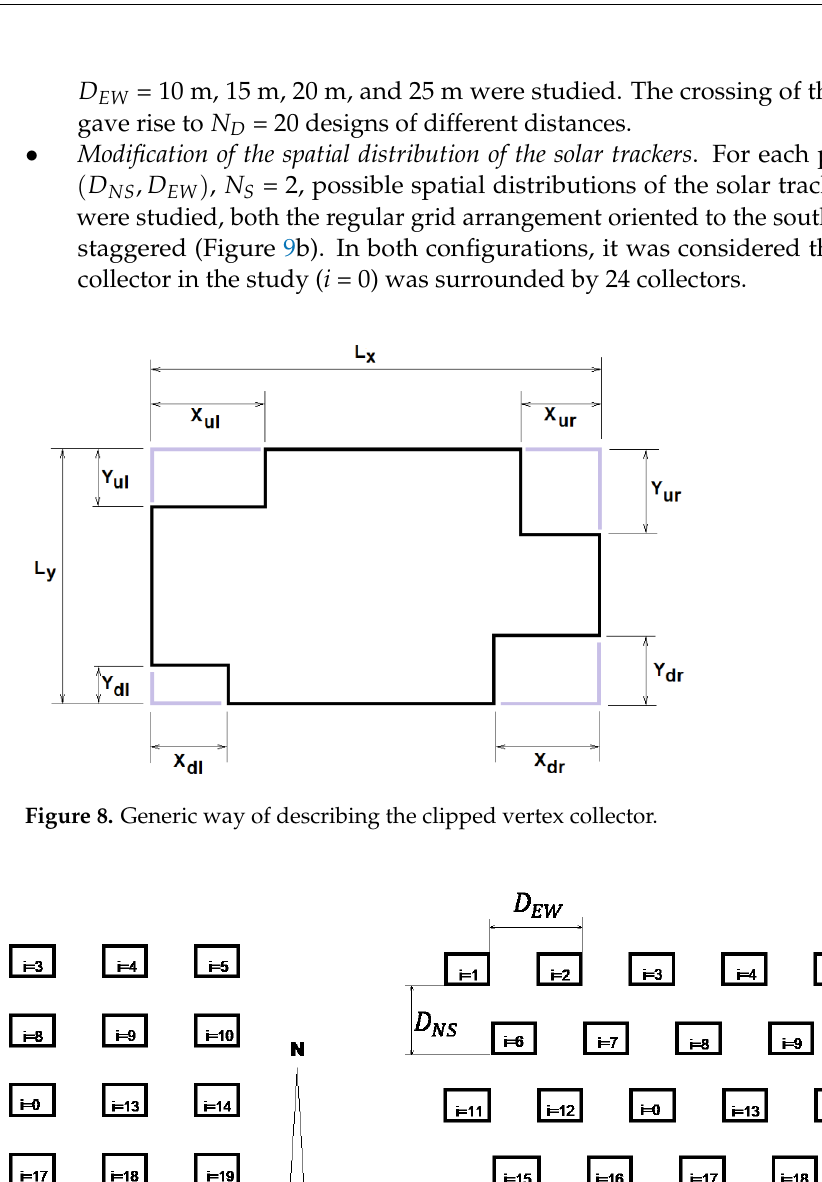
Figure 9. Considered spatial arrangements and location of the reference collector in the study (i = 0): ( a ) regular grid; ( b ) staggered .